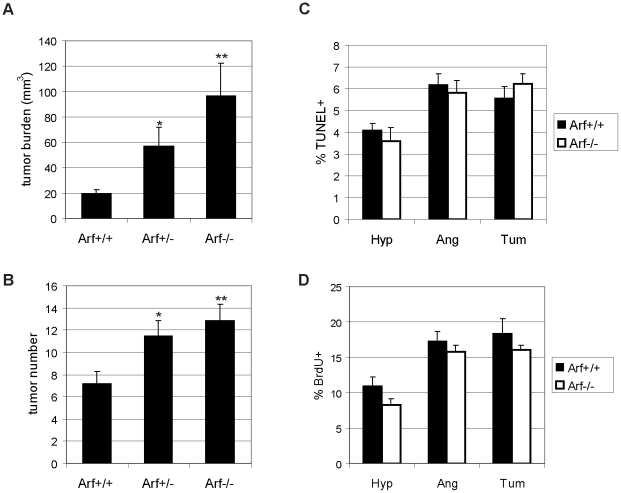
Genetic knockout of Arf accelerates RIP-Tag2 tumor progression without significantly affecting apoptosis/proliferation.(A,B) Effects of heterozygous and homozygous knockout of Arf on tumor burden (A; *p<0.001, **p<0.0001 compared to Arf+/+; the difference between Arf+/− and Arf−/− mice was not statistically significant) and tumor number (B; *p = 0.02, **p = 0.002) in 12 week-old RIP-Tag2 mice. Mean values +/− SEM from 15 (Arf+/+), 17 (Arf+/−), or 20 (Arf−/−) mice/group are indicated. Mann-Whitney test for statistical significance. (C) Apoptosis, as determined by TUNEL labeling in hyperplastic islets (Hyp), angiogenic islets (Ang), and tumors (Tum) from Arf+/+ or Arf−/− RIP-Tag2 mice. Mean values +/− SEM from graded lesions of 6–7 individual mice of each genotype are indicated. The number of total lesions analyzed for each genotype/lesion stage are as follows: Arf+/+ (Hyp: n = 27; Ang: n = 33; Tum: n = 14); Arf−/− (Hyp: n = 18; Ang: n = 25: Tum: n = 22). (D) Proliferation, as measured by the % of cells with BrdU incorporation in the different stages of islet lesions from 4 individual Arf+/+ (Hyp: n = 21; Ang: n = 24; Tum: n = 12) and Arf−/− (Hyp: n = 18; Ang: n = 22; Tum: n = 24) RIP-Tag2 mice.